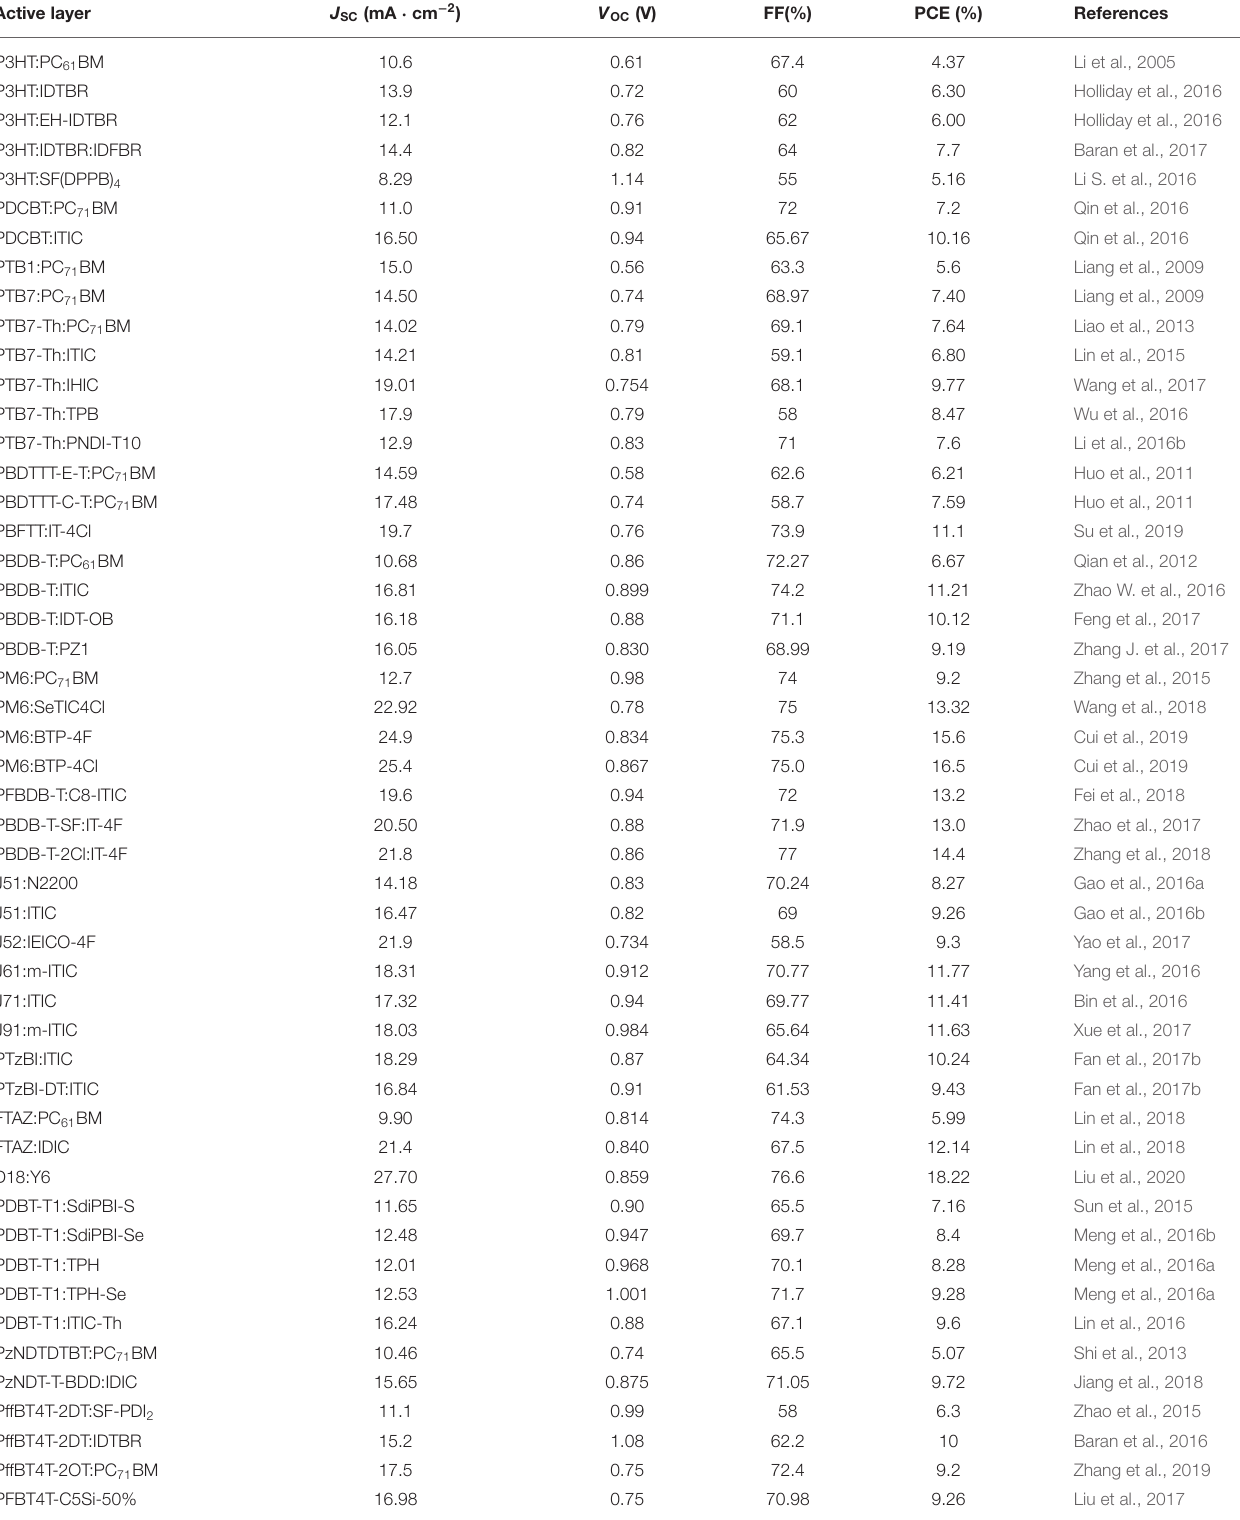
TABLE 1 | The BHJ OSCs devices performance of the presented materials. Active